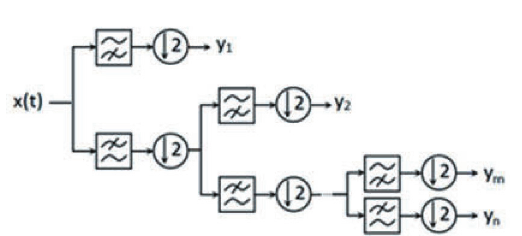
Fig. 4. Filter bank